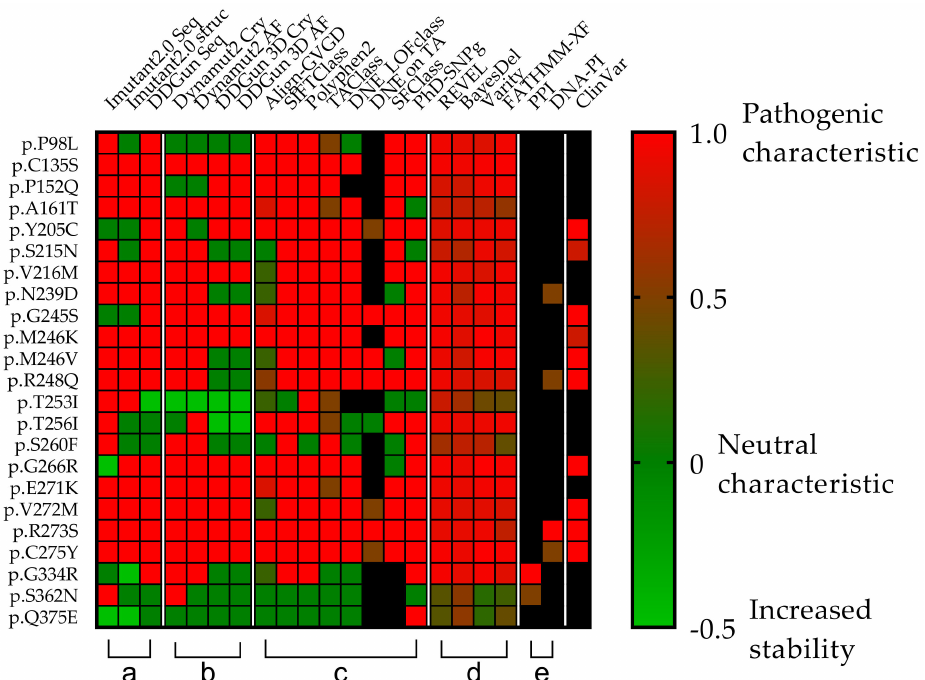
Figure 5. Comparison of the clinical relevance of the detected p53 mutations. Each row represents a p53 missense mutation, yet the columns represent protein stability predictions ( a , b ), different scoring systems ( c , d ), and interaction affinity studies ( e ) universally denoted by a color transition from green to red and corresponding value from 0 to 1, where the two endpoints are green = non-pathogenic and red = pathogenic). ( a , b ) Seq means sequence basis methods ( I-Mutant2.0 seq , DDGun seq ), Cry means wild-type protein crystal structures ( I-Mutant2.0 Cry , DynaMut2 Cry , DDGun 3D Cry ), and AF means protein structures generated with AlphaFold AI (DynaMut2 AF, DDGun 3D AF). Stability change was considered to be decreasing, if it was less than − 0.5 kcal/mol (score 1, red) and increasing (score − 0.5, light green) if it was higher than 0.5 kcal/mol, otherwise, the stability change of the mutation was considered as neutral (score 0, green). ( c , d ) Align-GVG represents the original C0 to C65 order on a color scale, where 0 = C0 and 1 = C65. SIFTCLass uses the pathogenicity class defined by Sift class, in the table 0 = benign, 1 = damaging. Polyphen2 class Benign = 0, possibly damaging = 0.5, probably damaging = 1. TAClass uses TransactivationClass classification, which divides variants into three functional categories “functional”, which is 0 in the figure, “partially functional” with a value of 0.5, and “non-functional” with a value of 1. DNE LOFclass indicates whether the mutation has a dominant-negative effect and loss-of-function effect (if yes, the value is